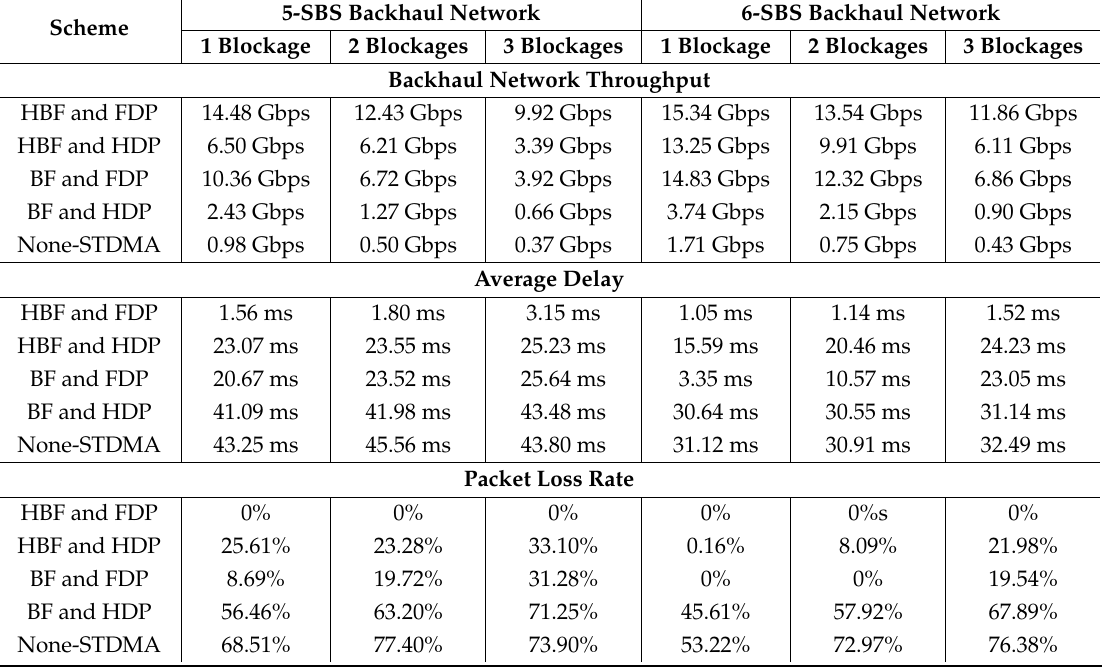
Table 2. System performance in scenarios of different numbers of small cell BSs (SBSs) and